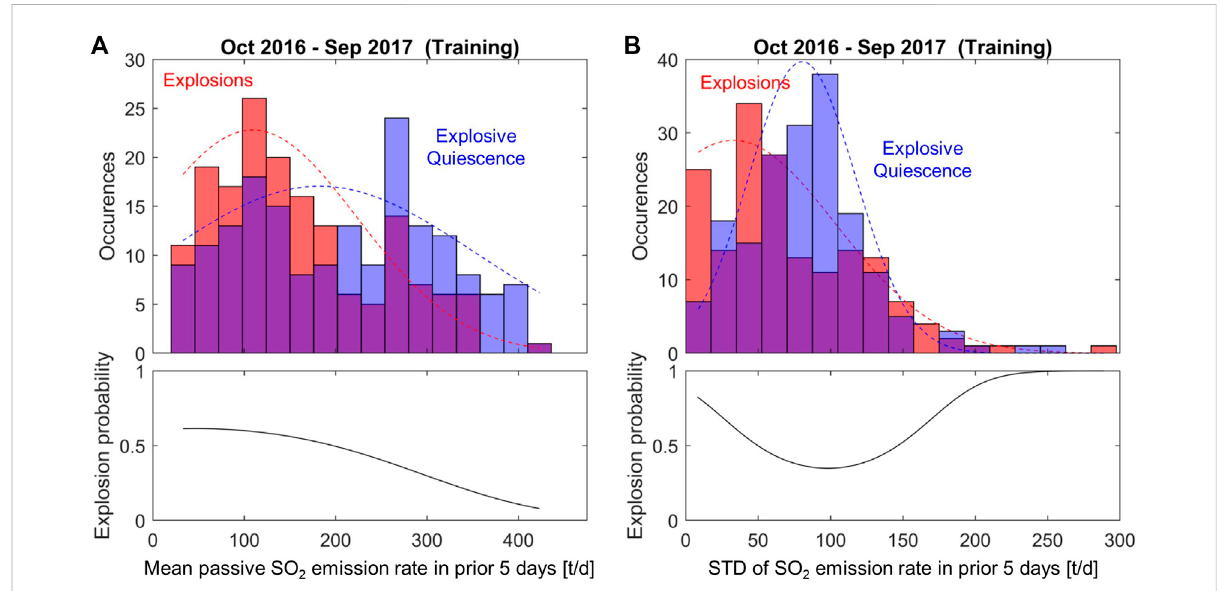
FIGURE 3 Results of a statistical analysis of SO 2 emission rates from Sinabung Volcano during October 2016 to September 2017. The mean (A) and standarddeviation (B) ofthepassiveSO 2 emissionrateinthe5 daysleadinguptoeachdayinthis1-yearperiodwerecalculated.Histogramsofthese parametershave been separated into days on whichexplosions occurred (red, N = 167)and days without explosions (blue, N =177).Areaswhere the histograms overlap appear purple. Note that days with explosions were more likely preceded by lower SO 2 emissions than days of explosive quiescence.Dayswithoutexplosionswere also typically preceded bystandard deviations (STD) ofSO 2 emission rates between 50and 150 t/d, while days with explosions were preceded by a somewhat wider range of variability in emissions. Fitting normal distributions to the histograms (dotted lines)andrequiringthatthesumofthetwoprobabilitiesequals1,anexplosionprobabilitywascalculatedforeachmeanandSTDvalue.Shownbelow each histogram, these probabilities are only valid for the period assessed here (October 2016 – September